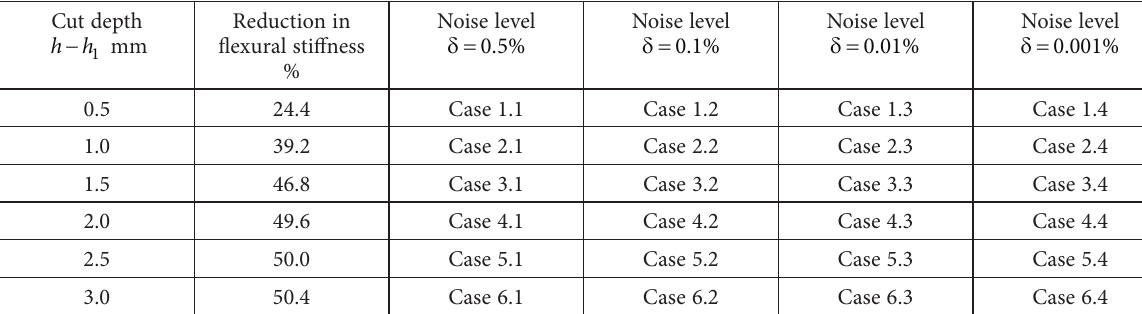
table 1. Simulated test